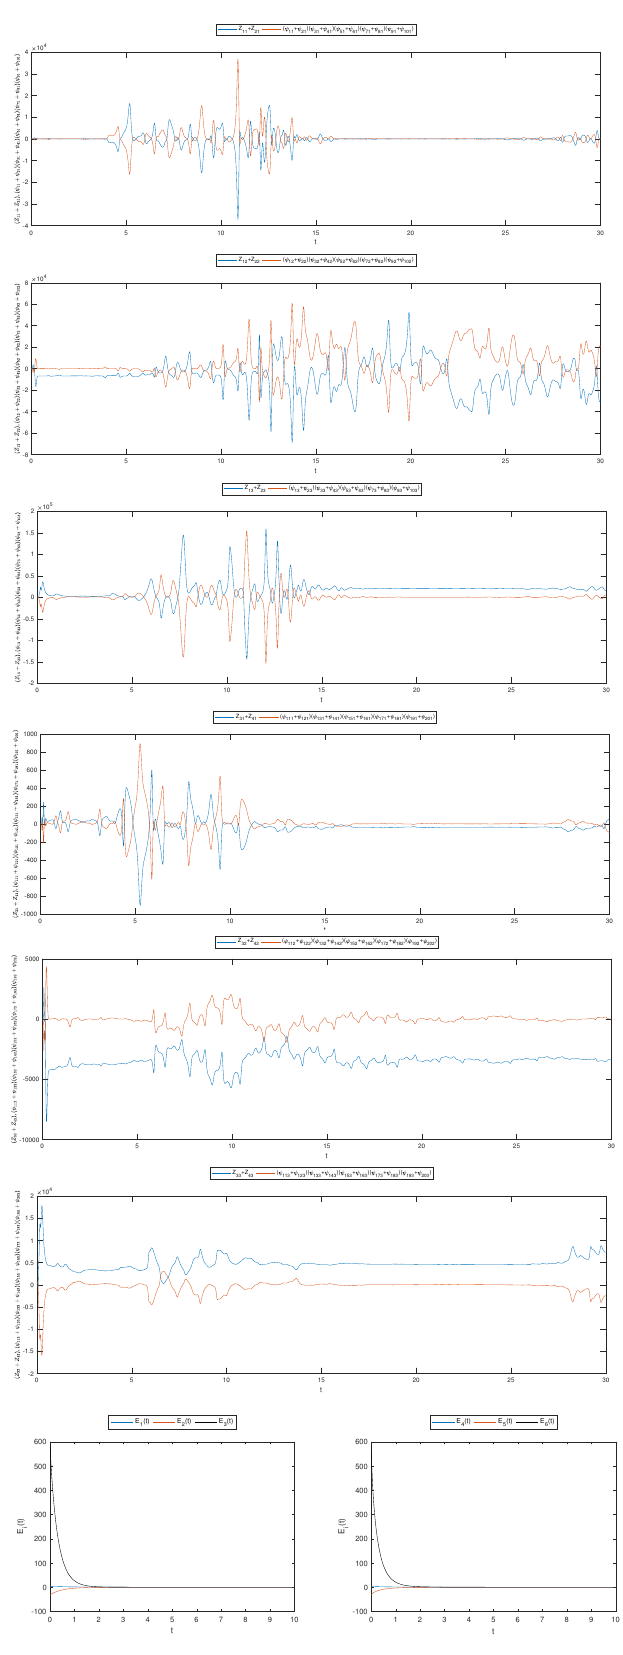
Figure 7. Synchronized trajectories and error via the non-linear control